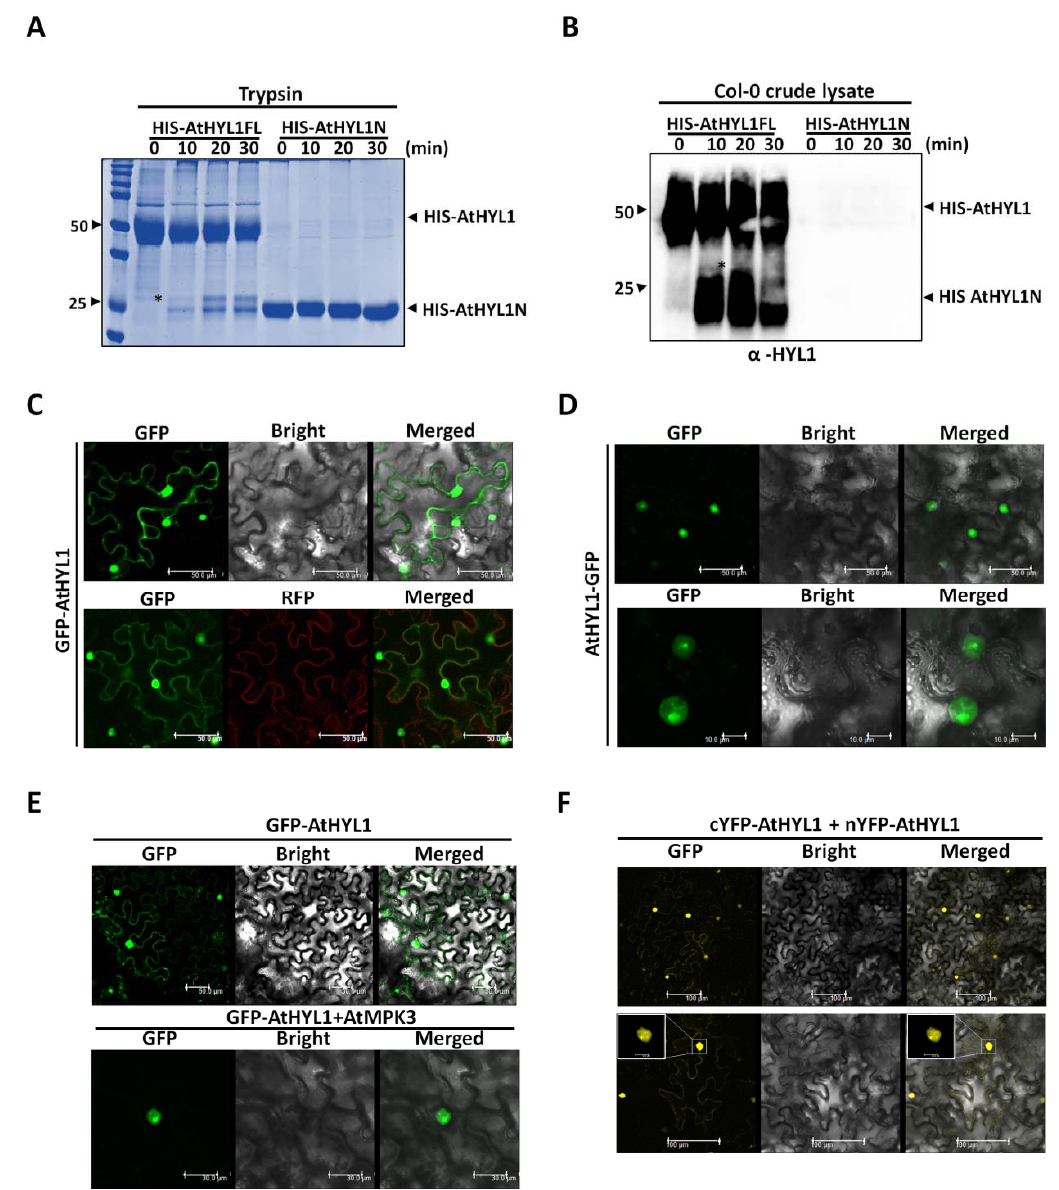
Figure 5. The nucleo–cytosolic shuttling of AtHYL1 is strictly regulated by the co-expression of AtMPK3 and its cytosolic proteolysis. ( A ) A CBB-stained SDS-PAGE showing the cleavage of HIS-AtHYL1 full length and truncated HIS- AtHYL1N by protease trypsin. The proteins were incubated with trypsin for the indicated times, followed by SDS-PAGE, and the gel was stained with CBB. ( B ) An in vitro protein degradation assay of bacterially purified HIS-AtHYL1 full length and truncated HIS-AtHYL1N incubated with crude protein extract (5 µg) from wild type A. thaliana (Col-0) for the indicated time periods, followed by immunoblotting with anti-HYL1. The asterisk indicates the cleaved product. The numbers on the left side are the protein molecular weights of the marker. ( C , D ) The localization of GFP-AtHYL1 ( C ) and AtHYL1-GFP ( D ) in N. benthamiana leaves were monitored under a confocal microscope. ( E ) The localization of GFP-AtHYL1 alone (upper) and with AtMPK3 in N. benthamiana leaves. ( F ) A BiFC assay showing the dimerization of cYFP-AtHYL1 and nYFP-AtHYL1 in N. benthamiana leaves. Nuclear dimerization is shown in the enlarged subset. The scale bar is shown in each figure section.